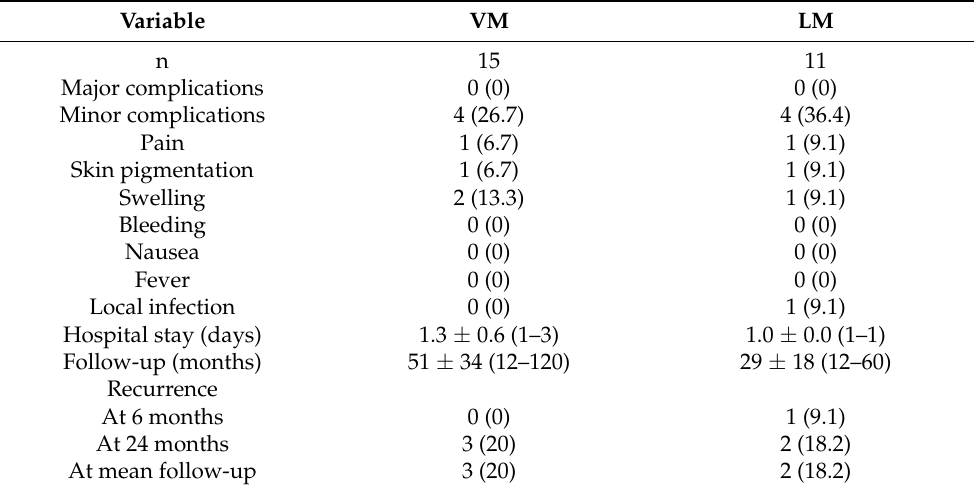
Table 3. Complications and